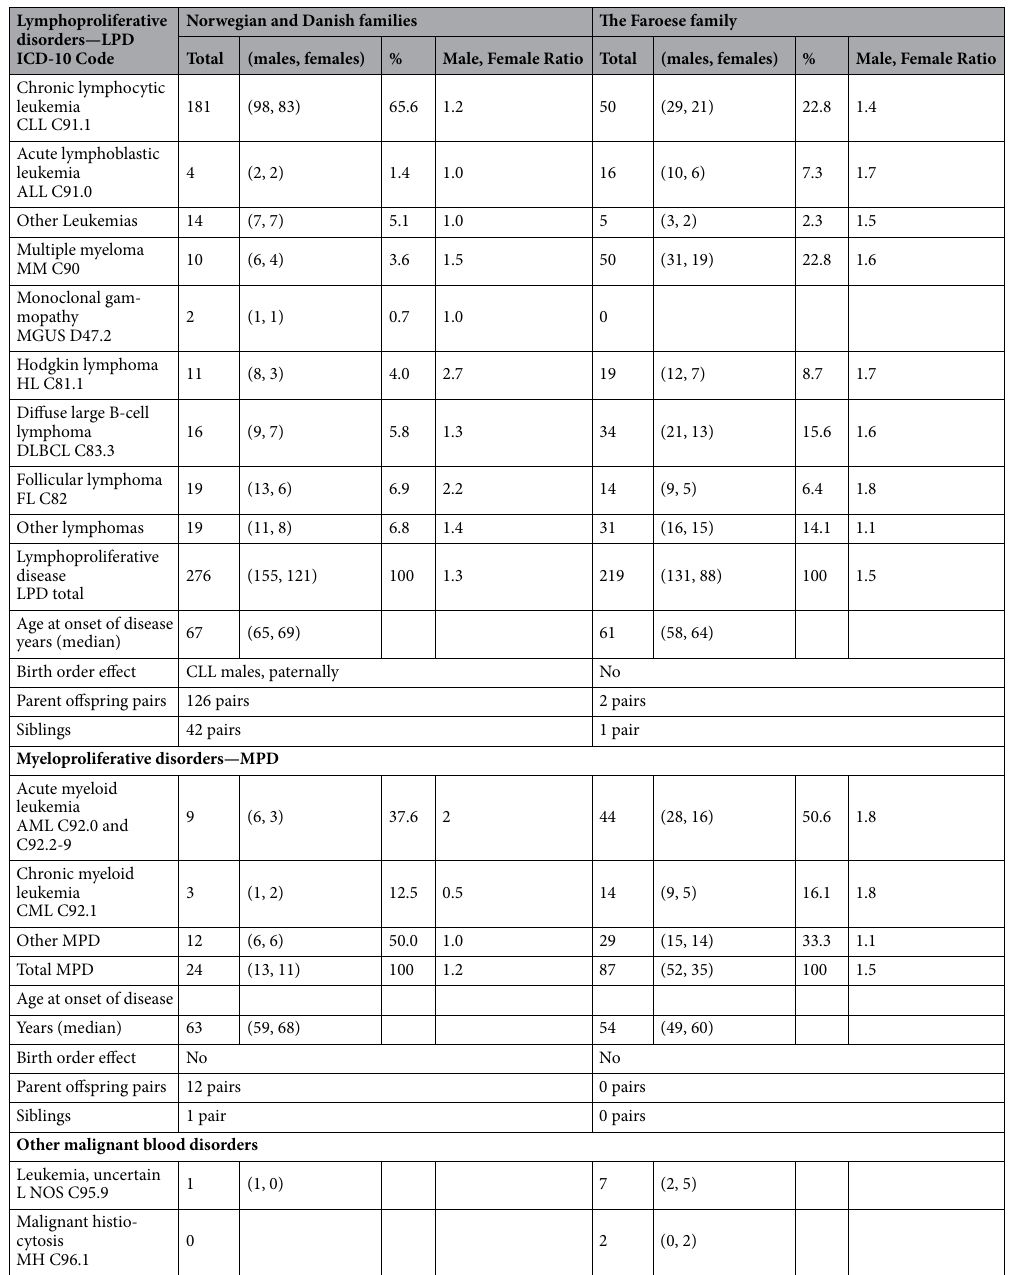
Table 1. Proband crude (PC) of familial malignant blood disorders. NOS, not otherwise